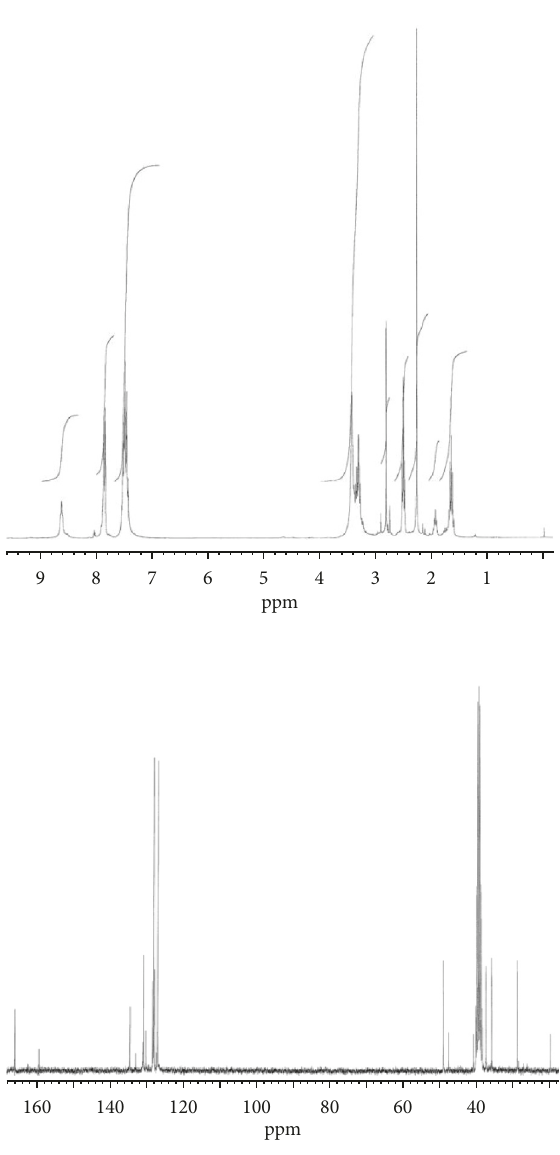
Figure 1: 1 H- and 13 C-NMR spectra for conformational isomers 5 - 6 . Rearranged product 5 contains no CON H ... NHCH 3 links. The − integration curve provides two CH 2 CH 2 CH 2 protons, they occur as a quintet absorption downfield relative to unrearranged 6 ; also the π electrons of the C O bond deshield the lateral zones in which the (cid:30) CH 2 NHCH 3 protons are